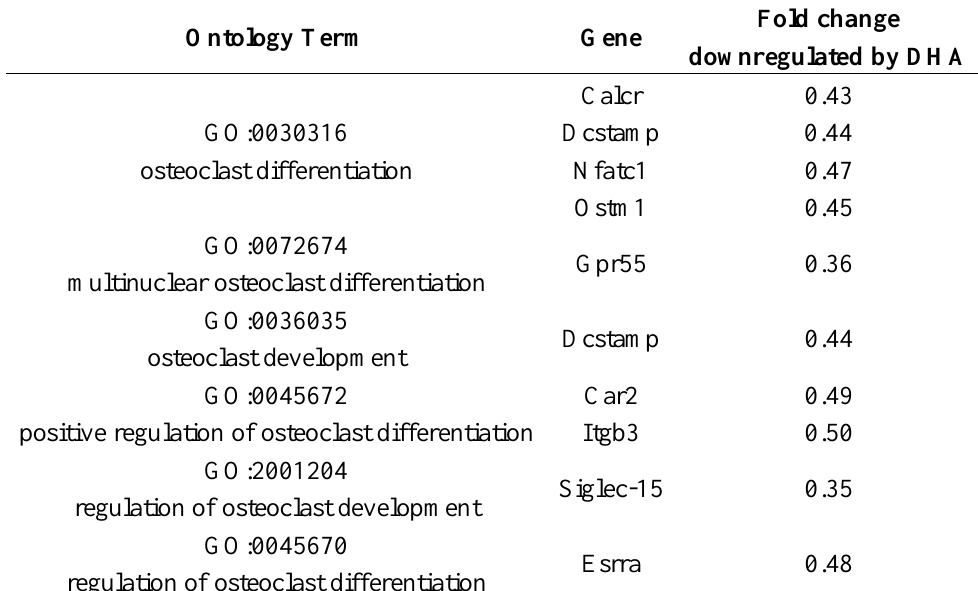
Table 2. Gene expression related to